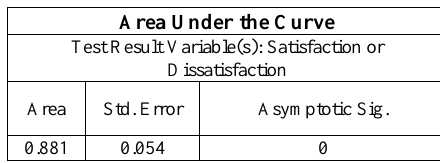
Table 5. Area under the curve